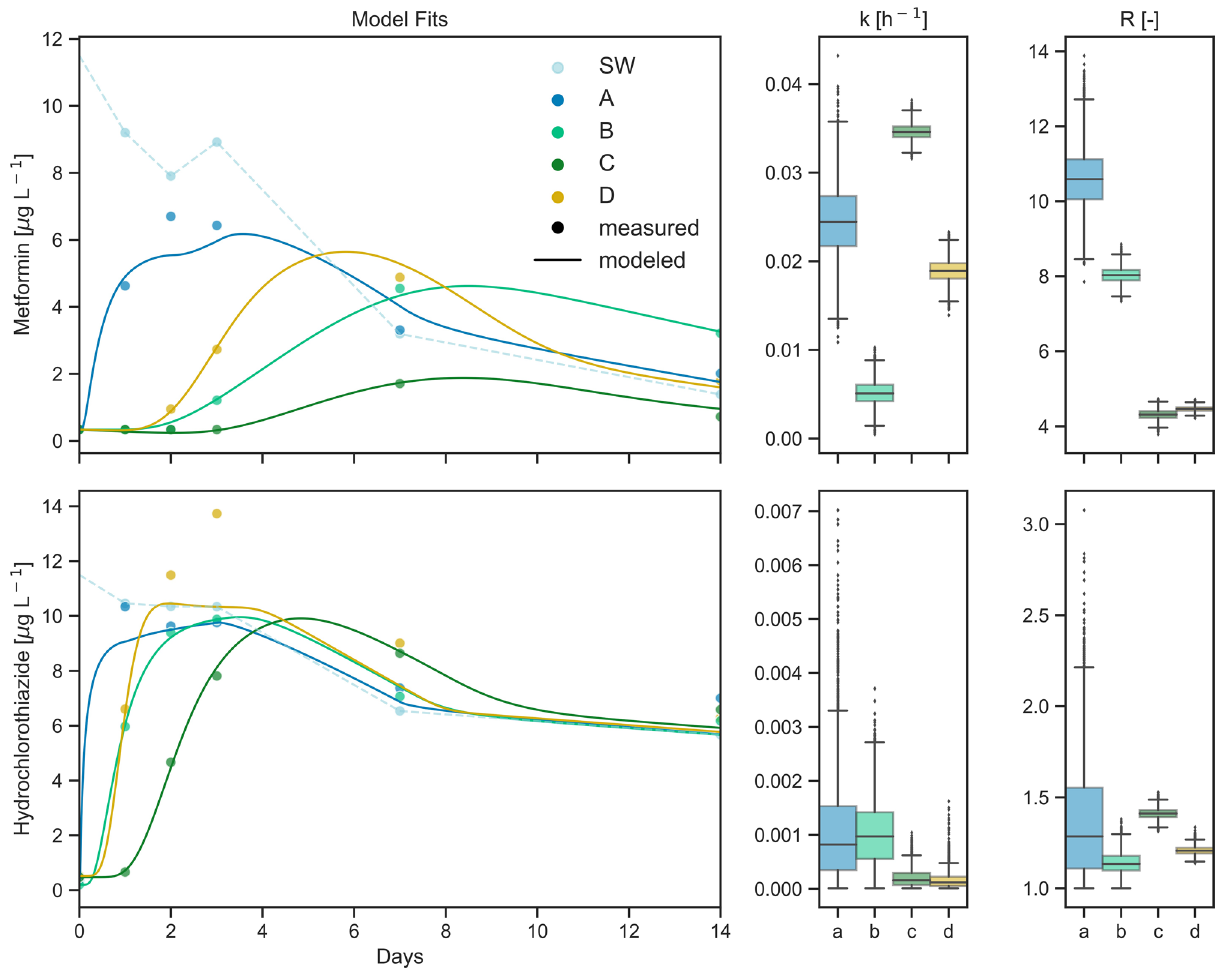
Figure 6. Measured concentrations and modeled breakthrough curves of metformin and hydrochlorothiazide in Flume 1. To the right, the estimated posterior distributions (n = 40,040) of the degradation rate constant k and the retardation coefficient R are given for each Flowpath a, b, c and d. For model results of all analysed compounds see Supplementary Figs. S5, S6, S7 and